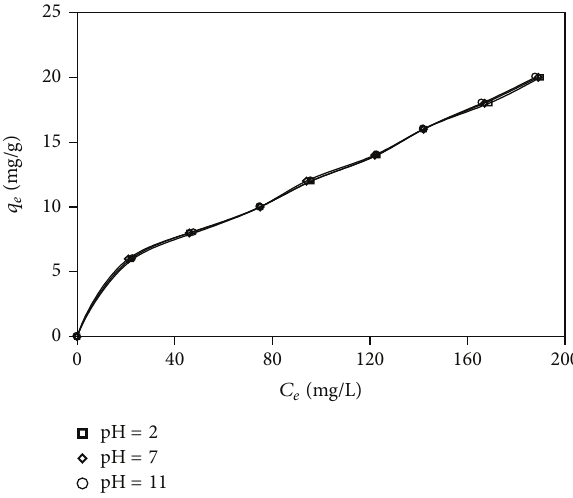
Figure 5: Plot of ln 𝐾 𝑐 versus 1/𝑇 for estimation of thermodynamic parameters for the adsorption of 3,5-xylenol and 2,6-xylenol onto asphaltene.